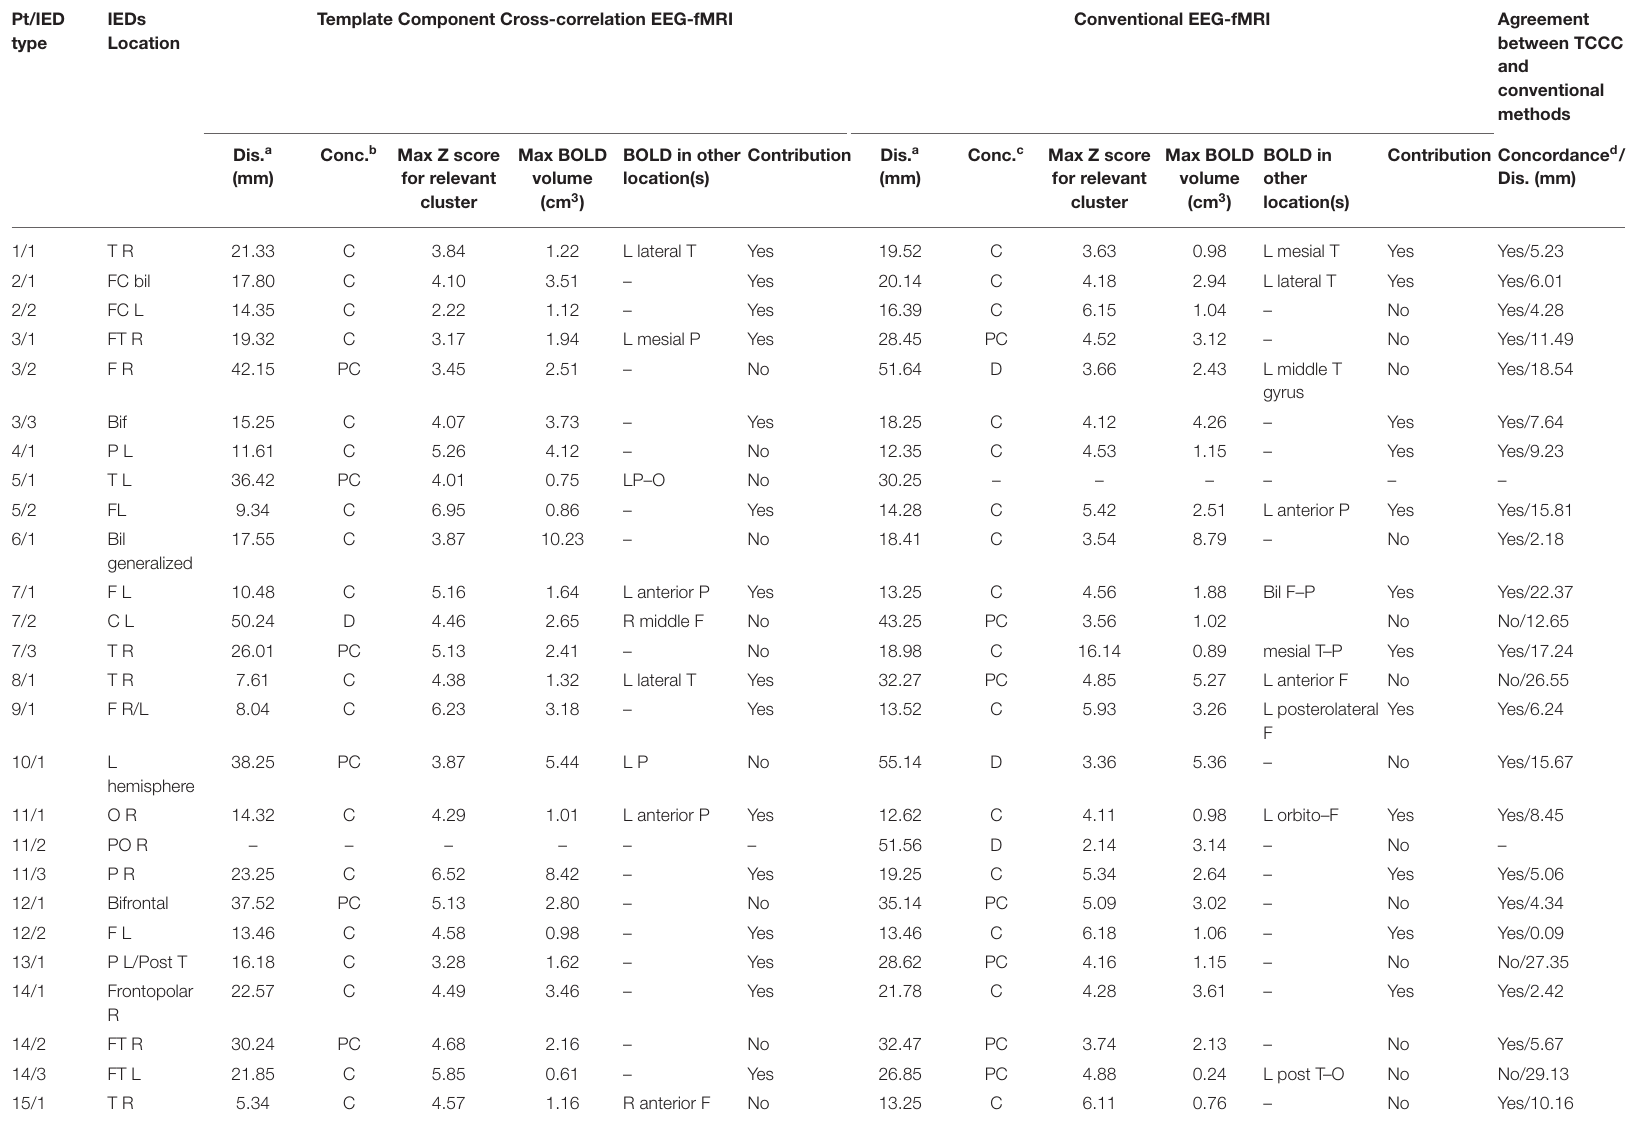
TABLE 3 | Comparison of concordance between conventional EEG-fMRI analysis and TCCC method in relation to BOLD response and EEG data of 47 IED studies. Pt/IED